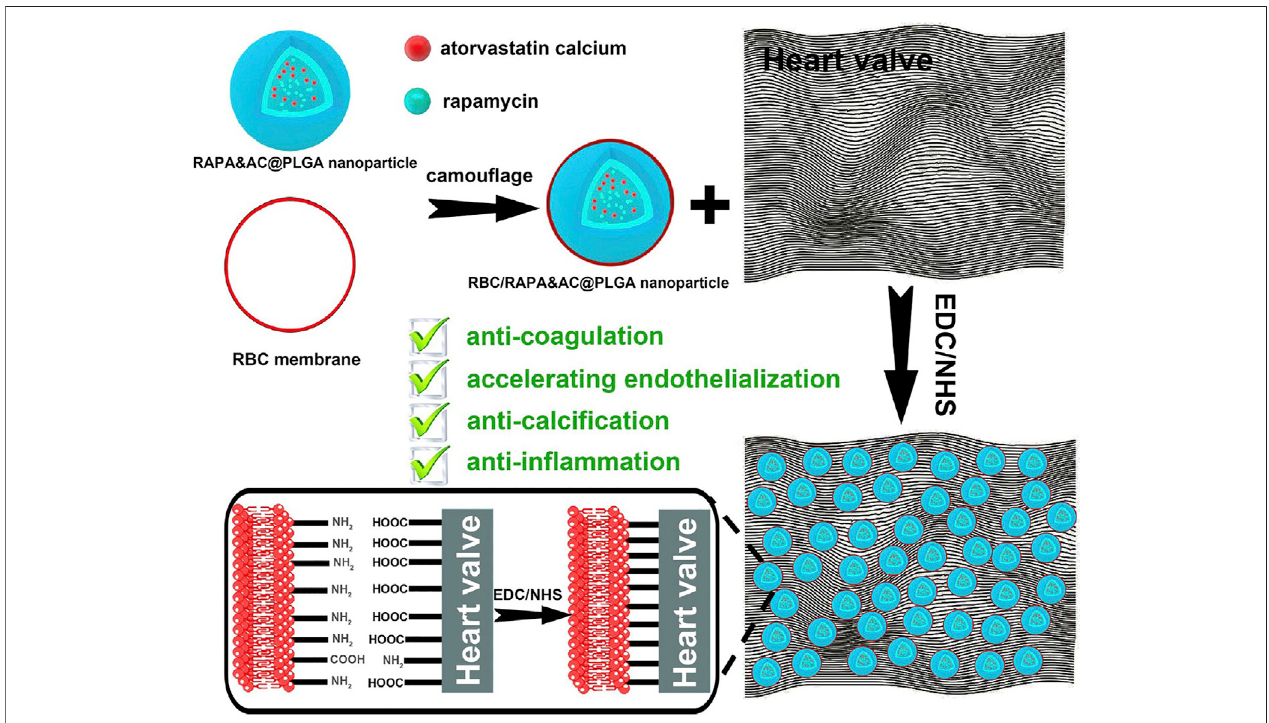
FIGURE 9 | Schematic of erythrocyte membrane biomimetic drug-loaded nanoparticles and mechanism of cross-linking with heart valves for anti-coagulation/ accelerating endothelialization process, anti-in fl ammation and anti-calci fi cation. Adapted from C. Hu et al. (2020). Copyright @ 2020 (American Chemical Society).